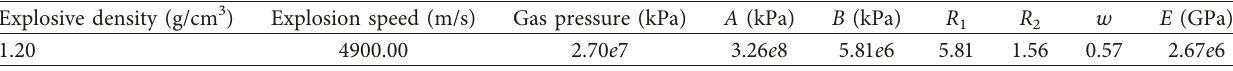
Table 2: Parameters of the explosive model.